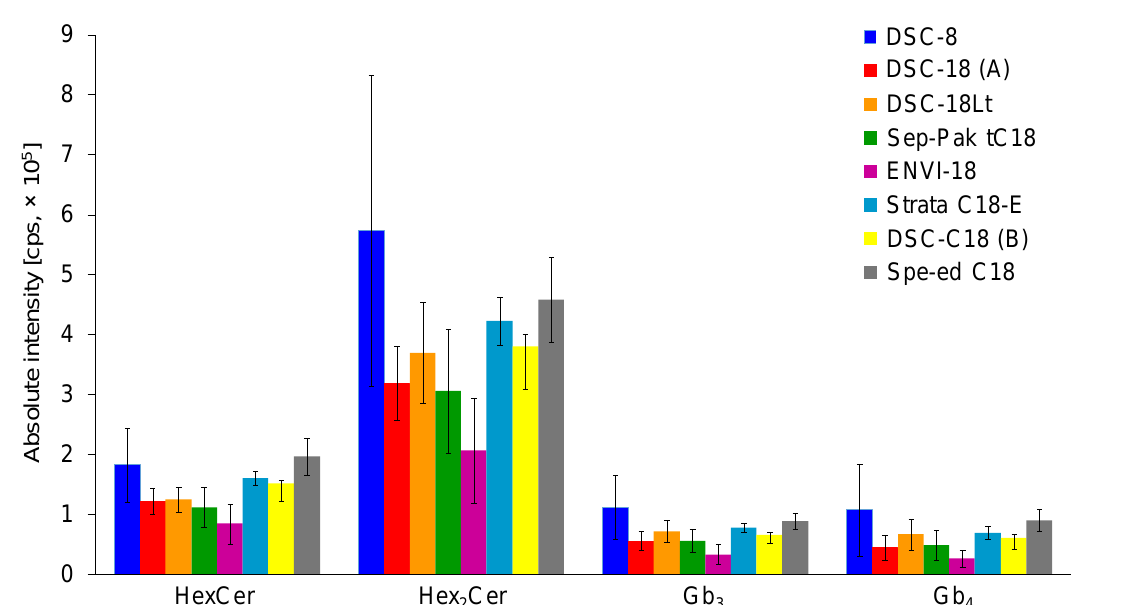
Figure 2. Comparison of C18-based solid-phase extraction (SPE) columns from different vendors using the same extraction protocol (see details in Experimental section). Bar graphs display means of absolute peak intensities of the most abundant species within particular GSL subclasses, and error bars illustrate standard deviations for 9 analyses (each SPE extraction was performed in triplicate and 3 measurements were performed for each sample).